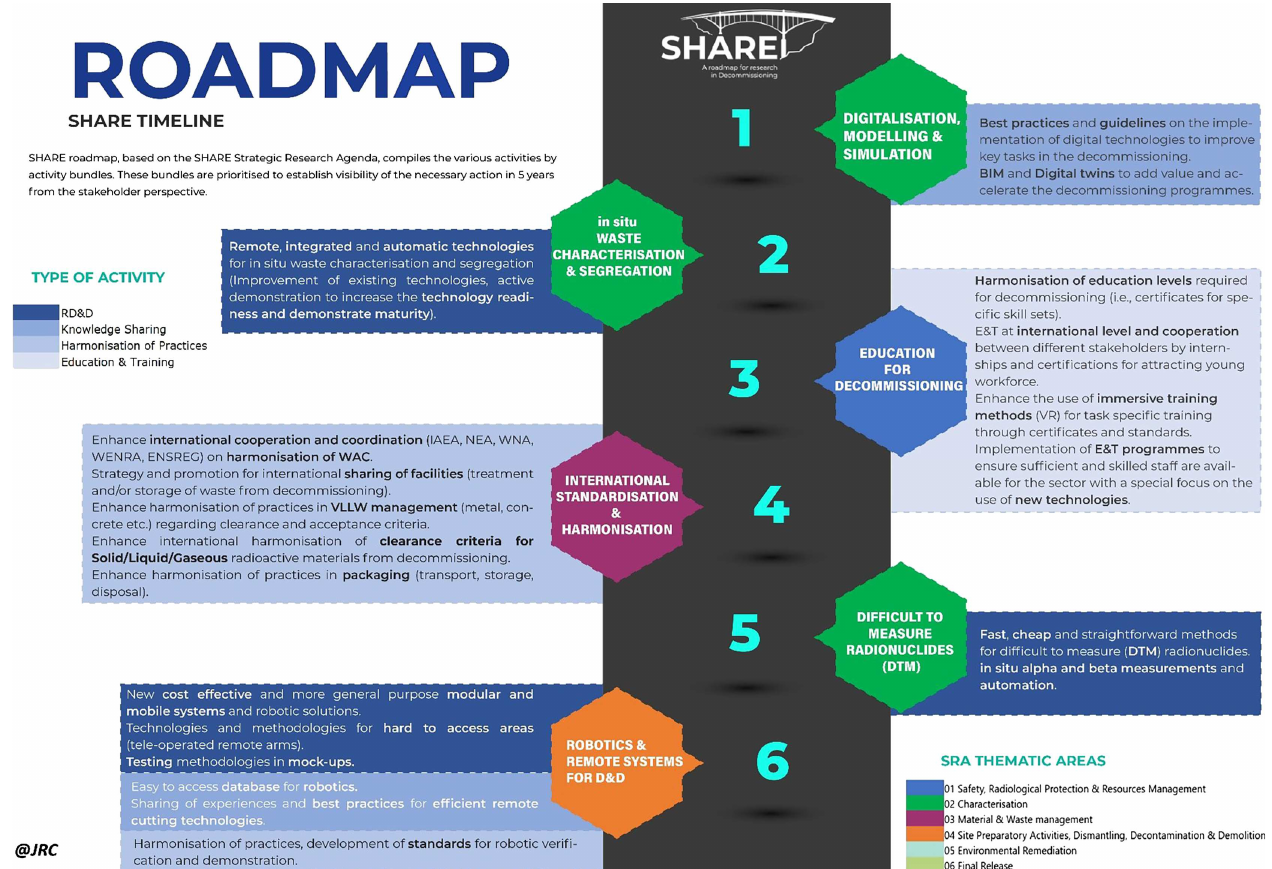
Fig. 10. SHARE Roadmap part